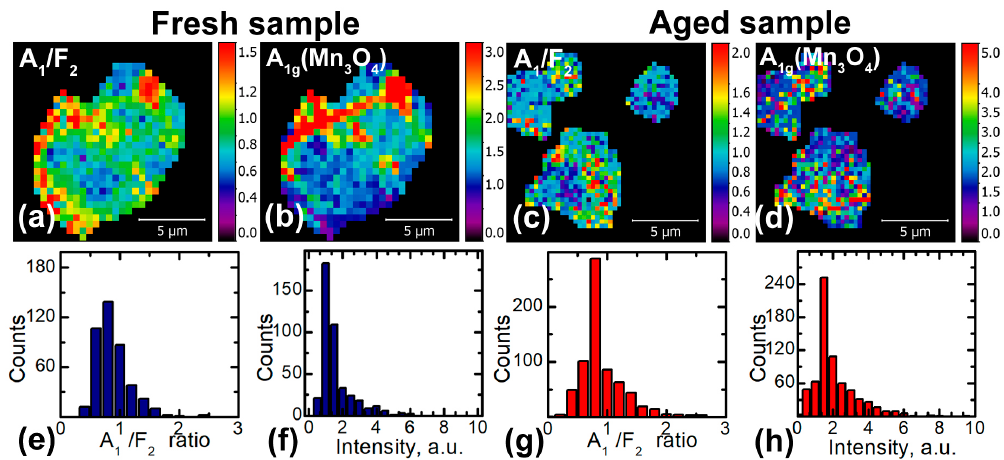
Figure 5. Mapping of the ( a , c ) ratio between A 1 /F 2 peak intensities; ( b , d ) intensity of A 1g peak related to Mn 3 O 4 phase in the active ionic particles of ( a , b ) fresh and ( c , d ) aged LMO cathodes; ( e – h ) histograms of the signal corresponding to maps ( a – d ). Delithiated state: Li 0.6 Mn 2 O 4 (100% SOC).